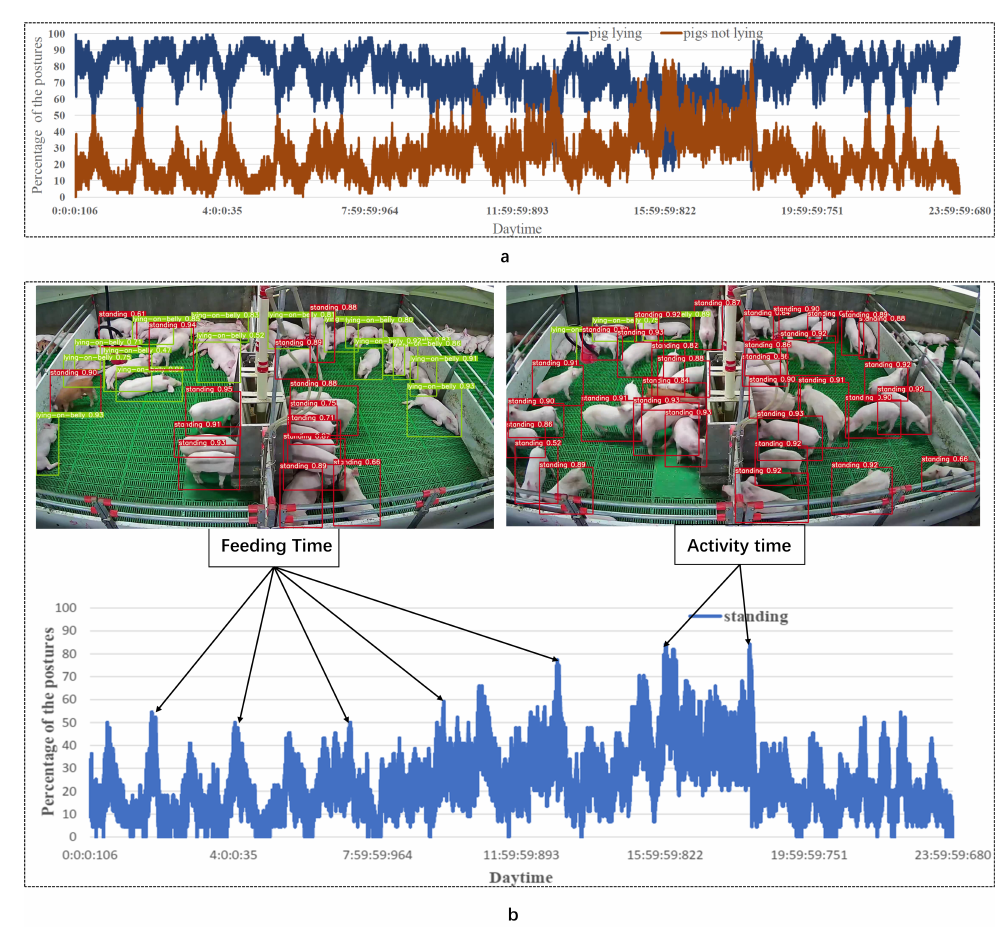
Figure 9. Analysis of pig postures. ( a ) Statistics of lying behavior of pigs in the nursery house for 24 h; the blue curve represents pig lying down, and the brown curve represents the pig not lying down; ( b ) Standing statistics of pigs in nursery house for 24